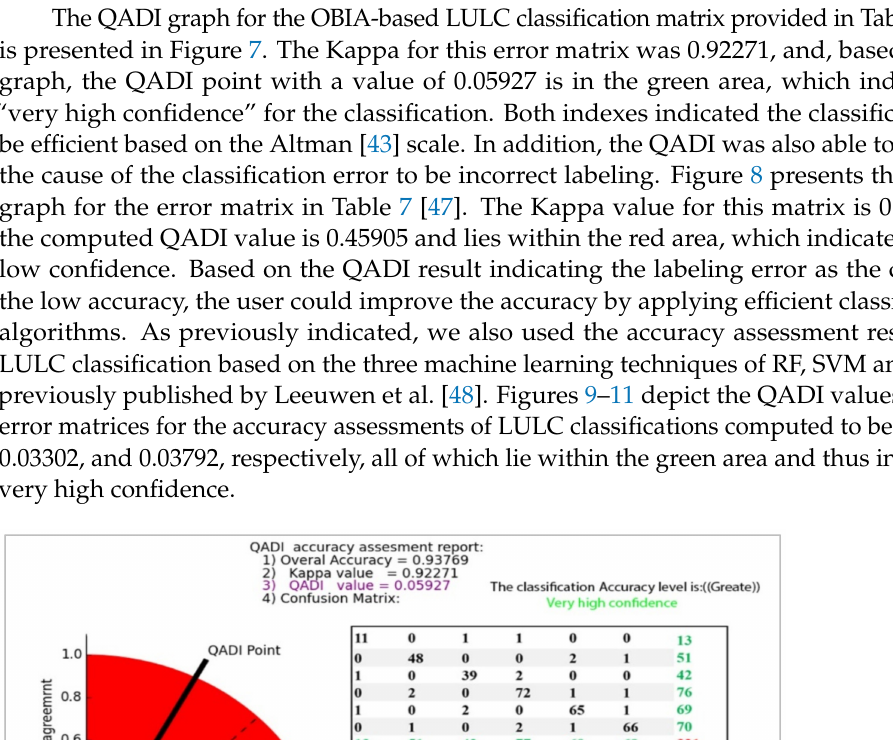
Figure 6. The QADI graph for the error matrix of the Sydney LULC classification.